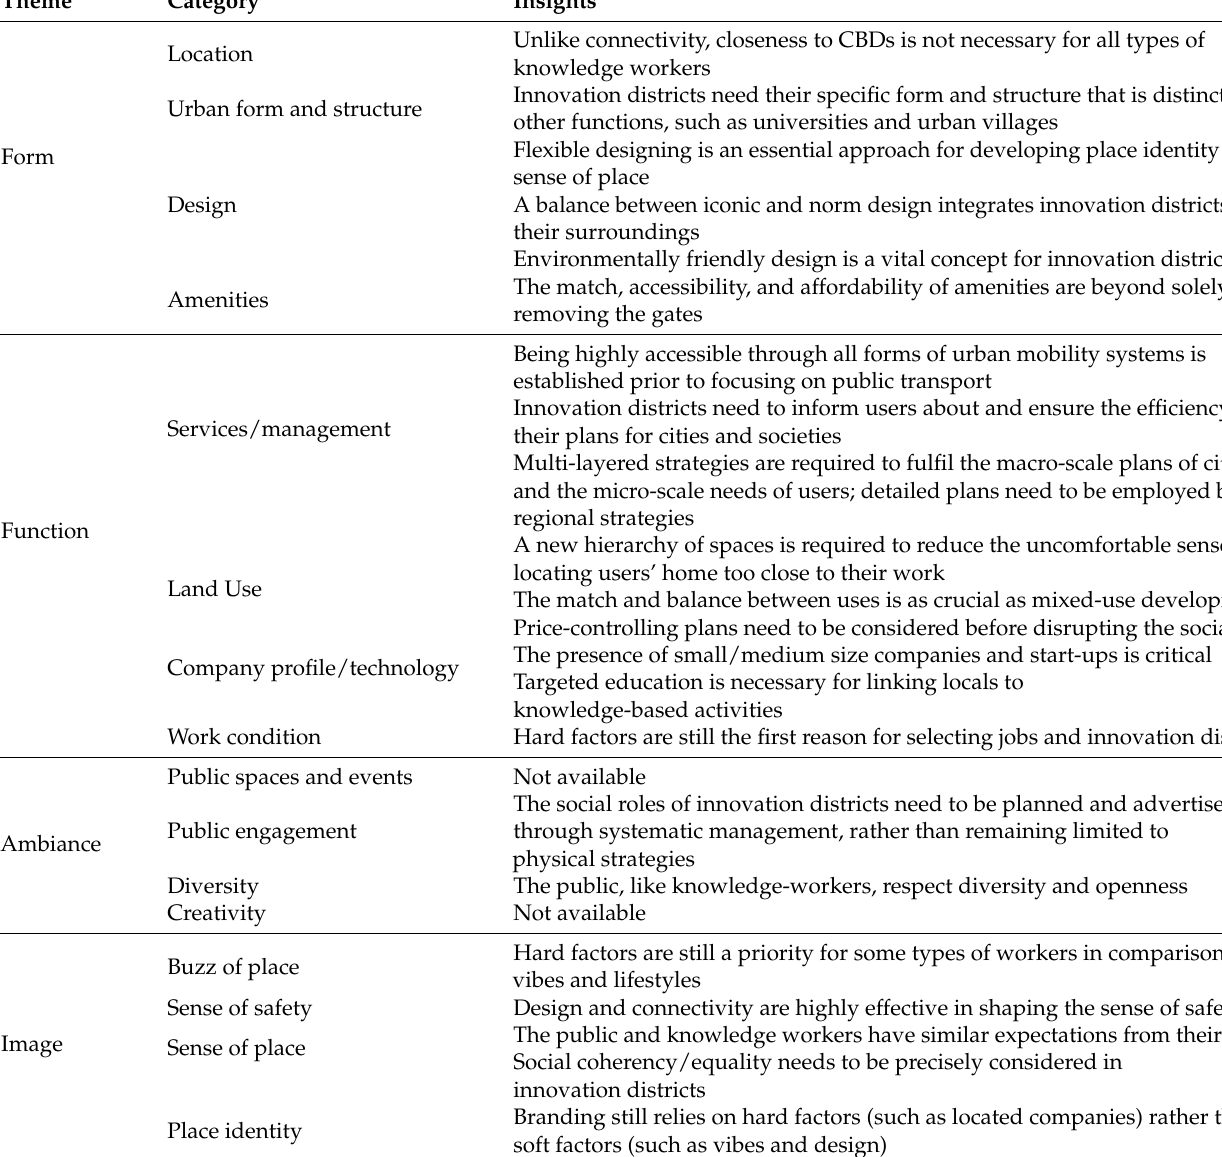
Table 5. Insights derived from